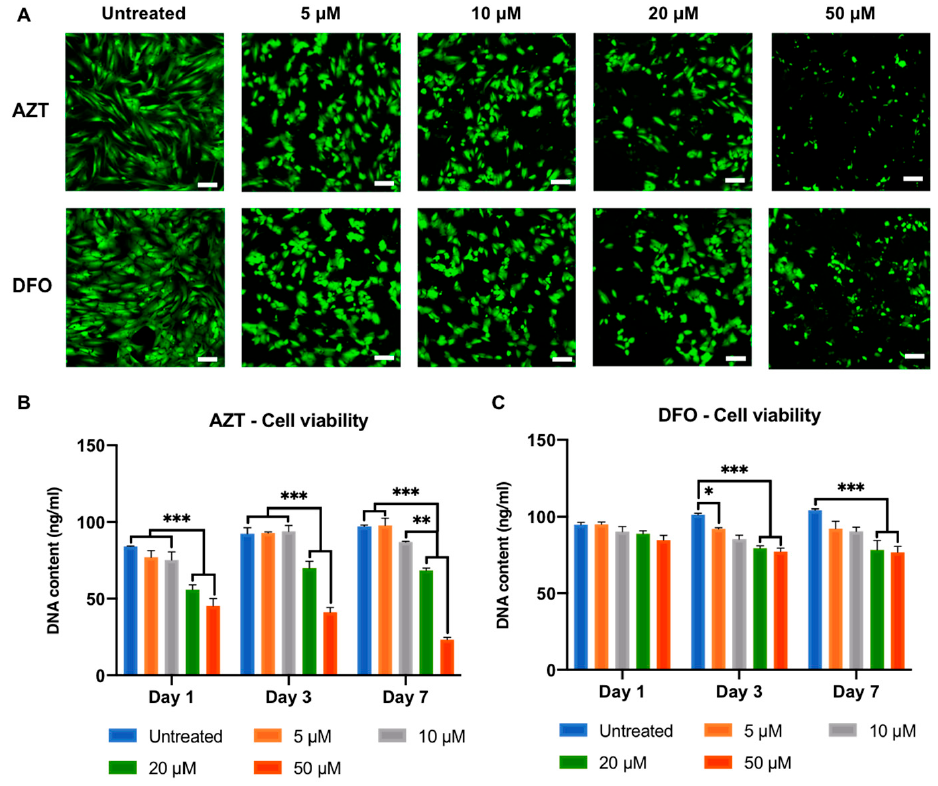
Figure 2. The effect of AZT and DFO on the morphology and cell viability of hBMSCs. AZT and DFO caused a time–dose dependent effect on the hBMSC ( A ) morphology and ( B , C ) DNA content. Data are expressed as mean ± SD ( n = 3). * p ≤ 0.05, ** p ≤ 0.01 and *** p ≤ 0.001. Scale bar = 50 µm.